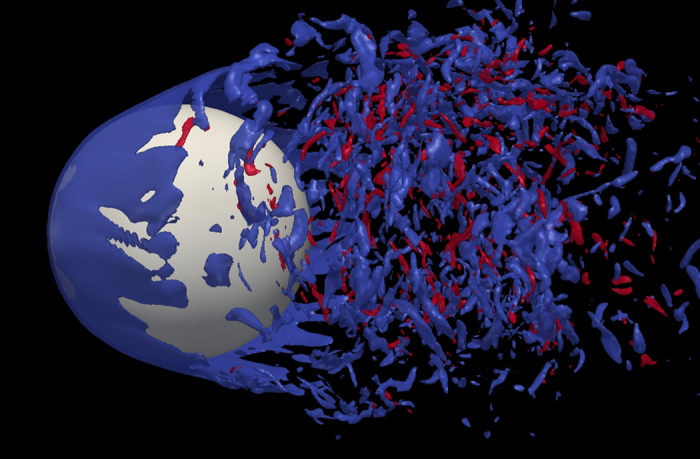
The snapshot of ωϕ for flow past sphere at Re = 105.